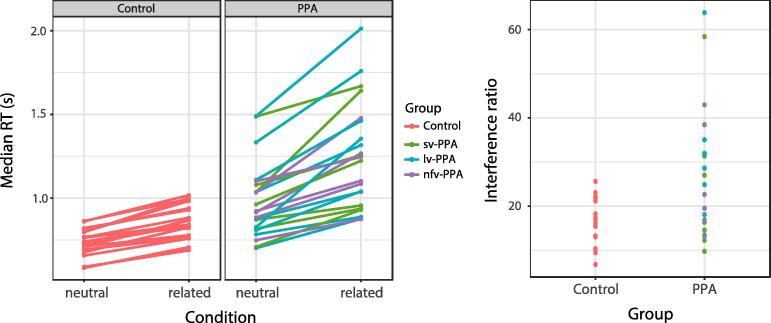
Individual median response time per noise condition for each group (left) and interference effect as percentage increase in RT relative to the neutral condition, i.e., (RT related – RT neutral)/RT neutral (right). RT = response time.